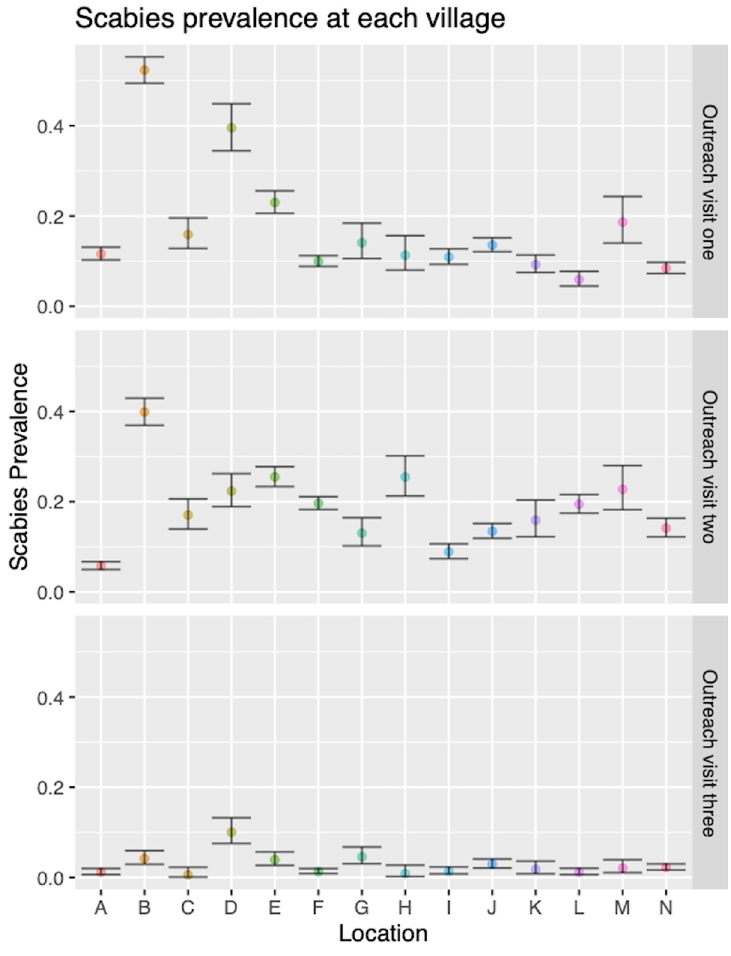
Fig 3. Scabies prevalence by village at each of the three community outreach events conducted by the DerMalawi Project.